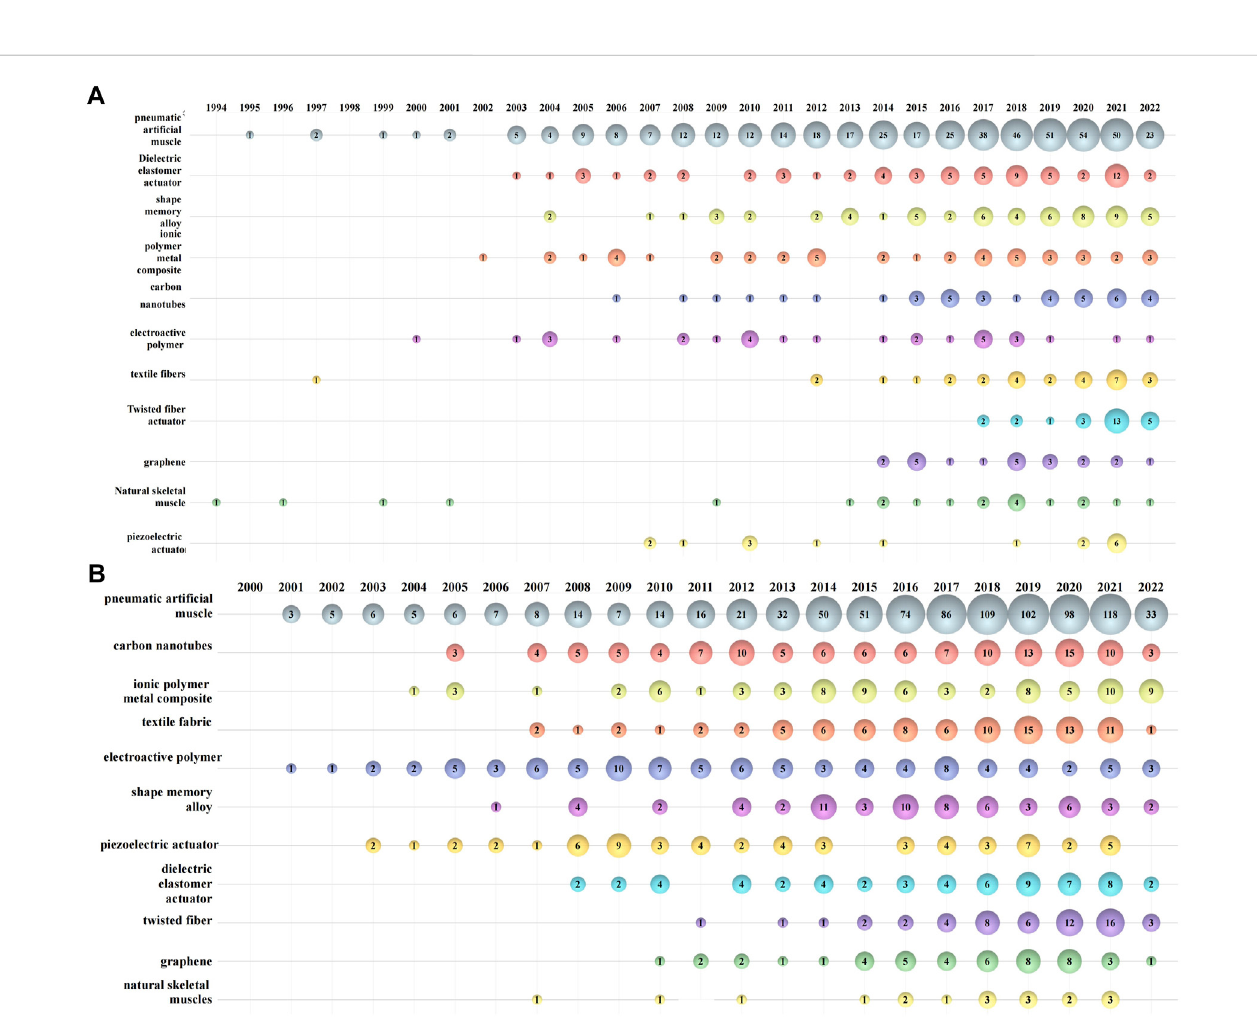
Frontiers in Bioengineering and